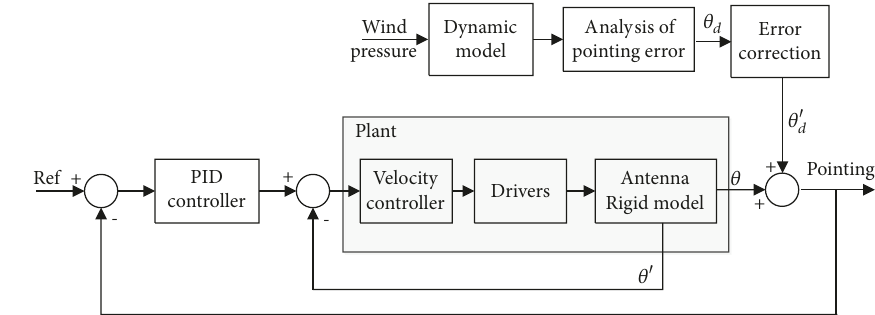
Figure 15: Antenna servo system.